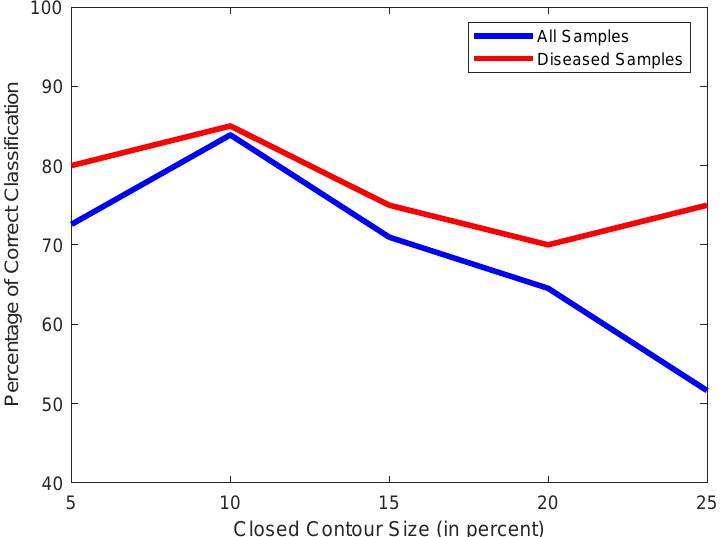
Figure 9. Plot of classification accuracies of all samples (blue) and only diseased samples (red) vs. contour